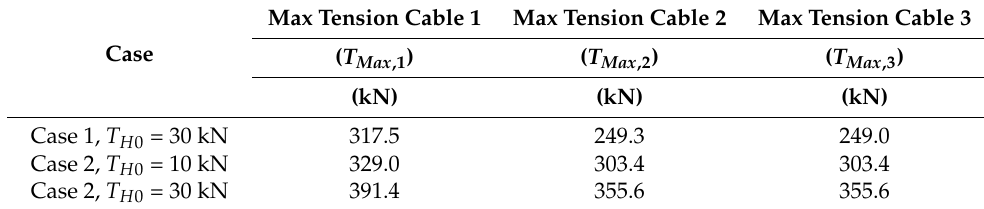
Table 19. MPME tension values calculated on each fairlead.